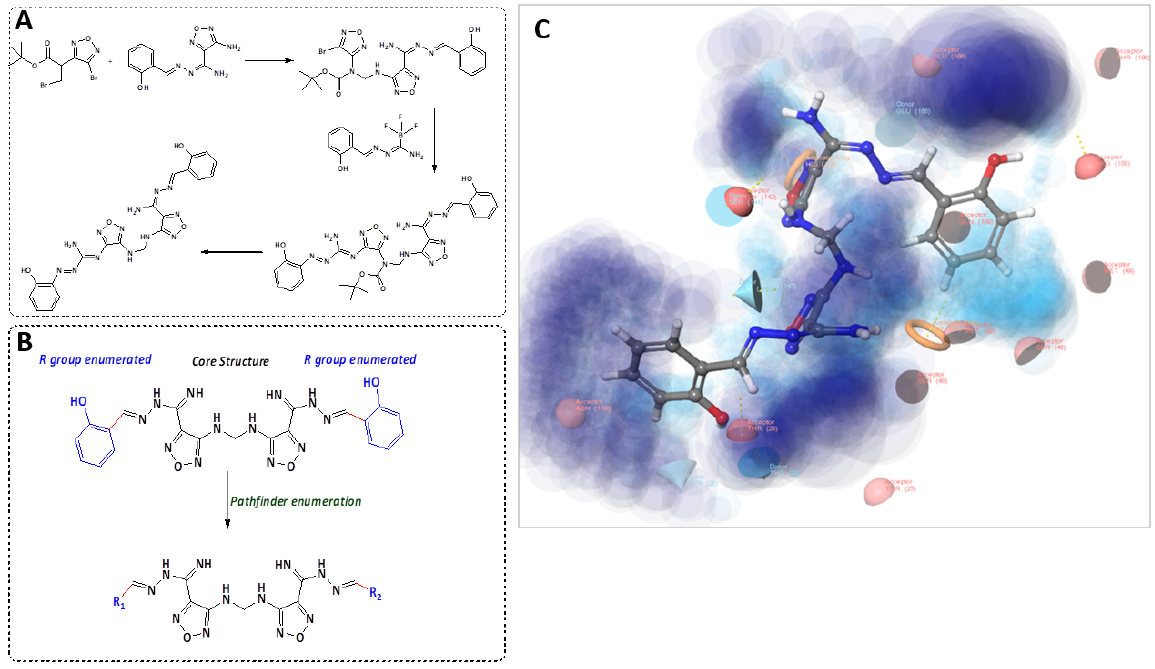
Figure 3. Enumerated structure design by PathFinder. ( A ) Proposed synthetic route for the synthesis of Compound 13 . ( B ) R-group enumeration. ( C ) Ligand designer of Compound 13 with M pro binding pocket. Light blue shows the cavity space and dark blue shows the solvent exposure workflow.